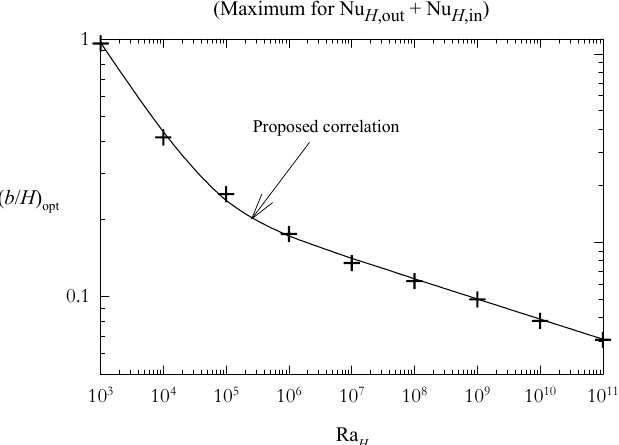
Figure 5. Thermally optimum plate–plate spacing ( b / H ) opt as a function of Rayleigh number Ra H . Configuration is given in Figure 1b. Heating intensity Λ = 0.01. Proposed correlation is given by Equation (11).